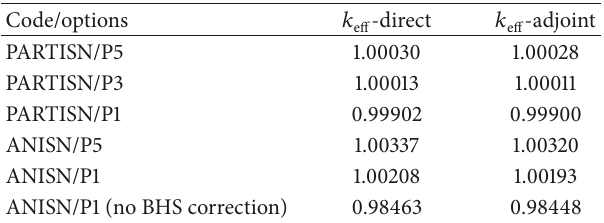
Table 2: Multiplication factors calculated using the PARTISN and ANISN codes using P 1 and P 5 Legendre expansion. BHS indicates that the Bell-Hansen-Sadmeister transport correction was used. Note an excellent agreement between the direct and adjoint calculations, within few pcm for PARTISN, and within ∼ 15 pcm for ANISN